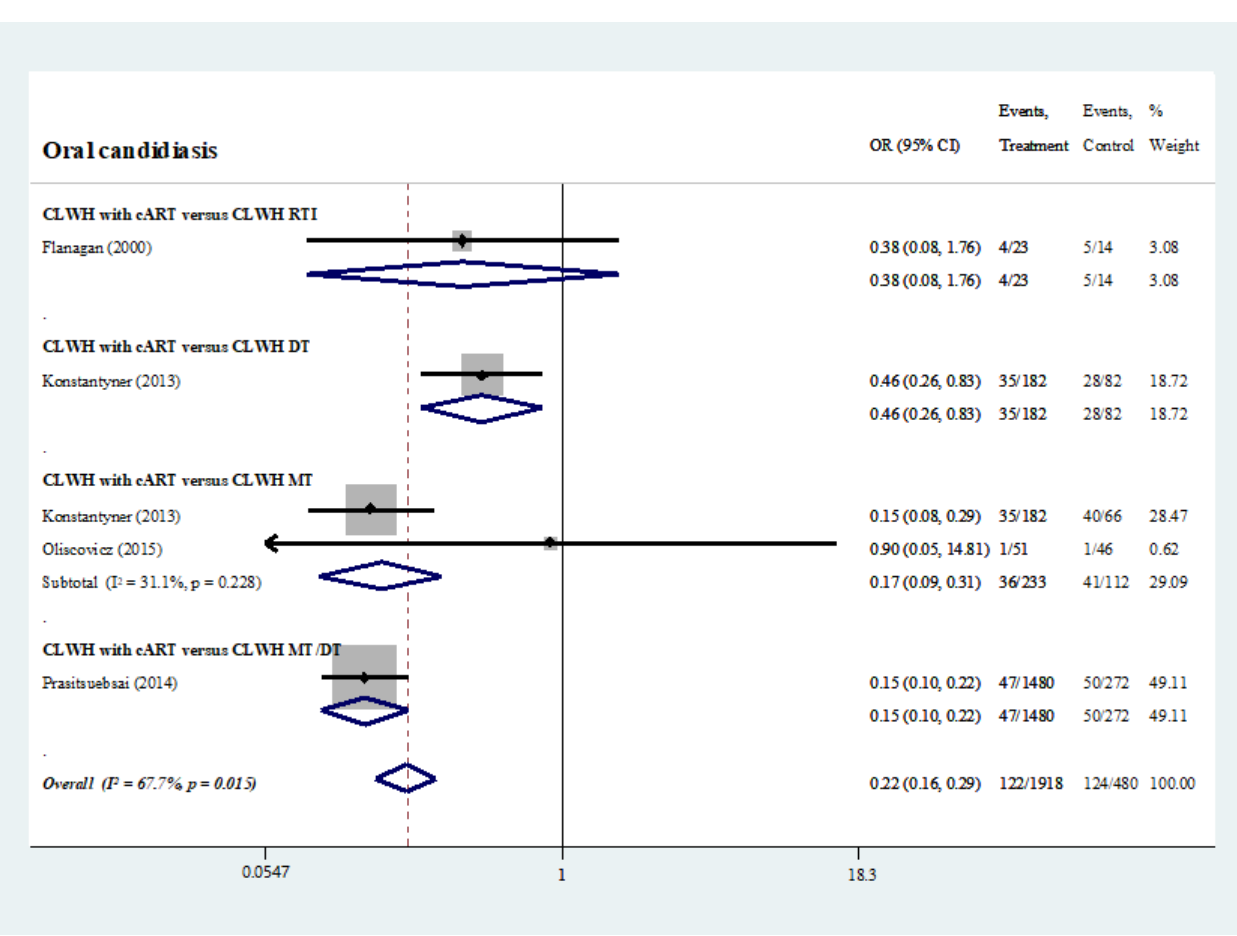
Figure 5. Prevalence of oral candidiasis: HIV-infected individuals under different antiretroviral medication